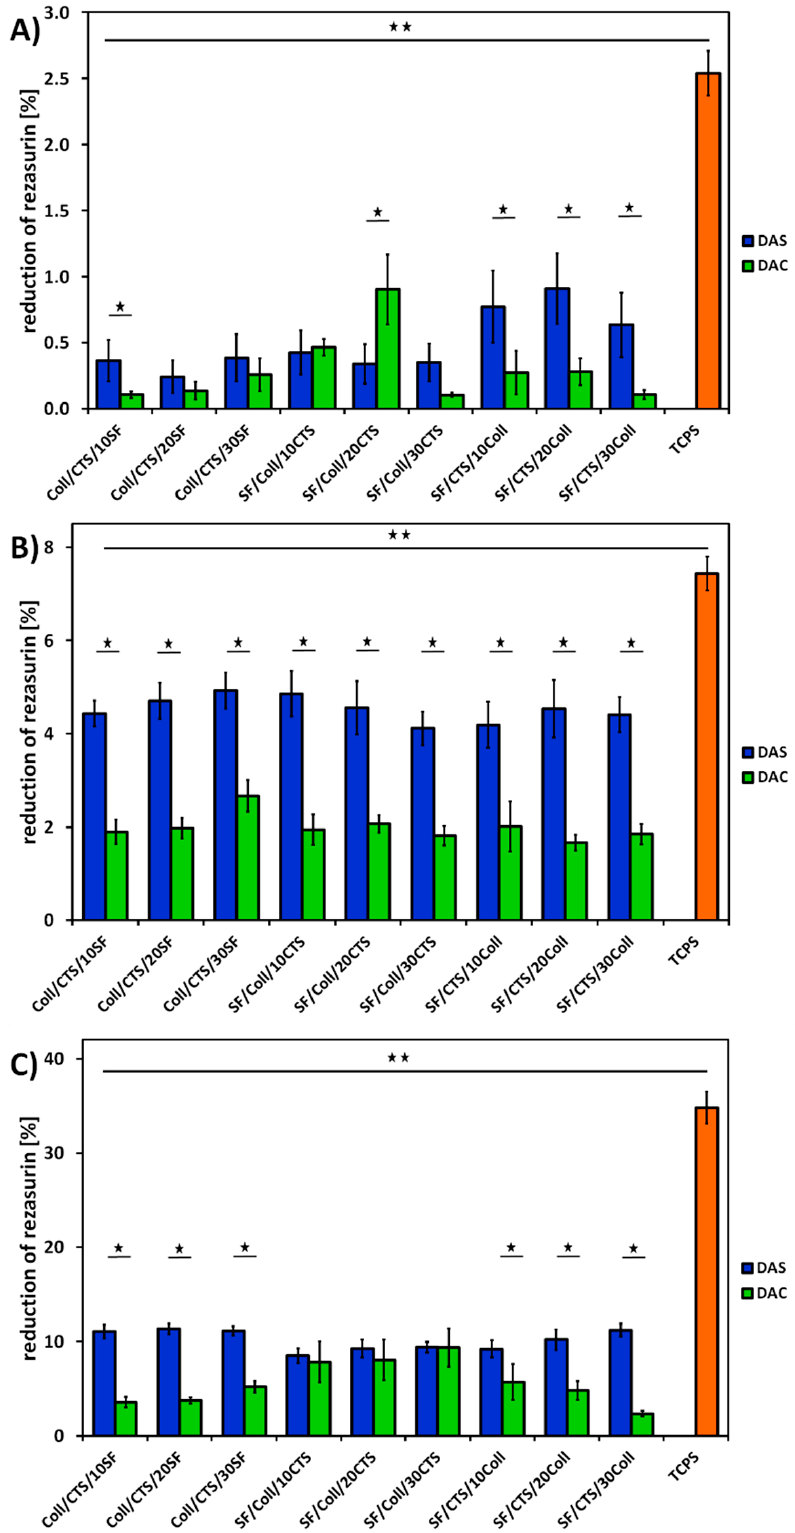
Figure 12. Metabolic activity expressed as reduction of AlamarBlue on days 1 ( A ), 3 ( B ), 7 ( C ) of MG-63 cells cultured on scaffolds cross-liked with dialdehyde starch (DAS) and dialdehyde chitosan (DAC) and on control TCPS (tissue culture polystyrene). Results are presented as mean ± standard error of the mean (* p ≤ 0.05 between cross-linkers; ** p ≤ 0.05 vs. TCPS according to one-way ANOVA with Holm–Sidak post hoc test, GraphPad Prism 8.0.1.244).